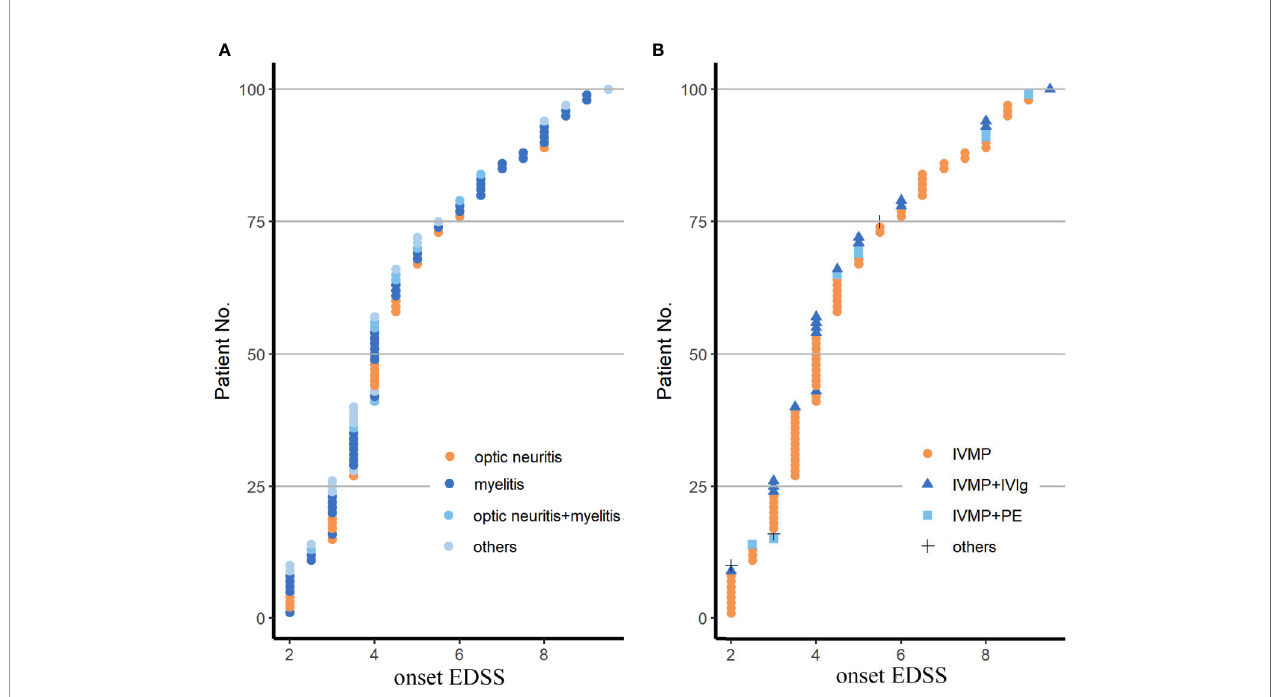
FIGURE 2 | Demyelinating phenotypes (A) and therapeutic patterns (B) in the cohort. EDSS, Expanded Disability Status Scale; IVMP, intravenous methylprednisolone pulse therapy; IVMP+PE, IVMP combined with plasma exchange; IVMP+IVIg, IVMP combined with intravenous immunoglobulin; others in (A) included 9 patients with a brainstem syndrome, 5 with a cerebral syndrome, 6 with a diencephalic syndrome, 4 with a area postrema syndrome with or without ON or MY; others in (B) were 3 patients treated with oral glucocorticoid. Fisher ’ s exact test was used for statistical